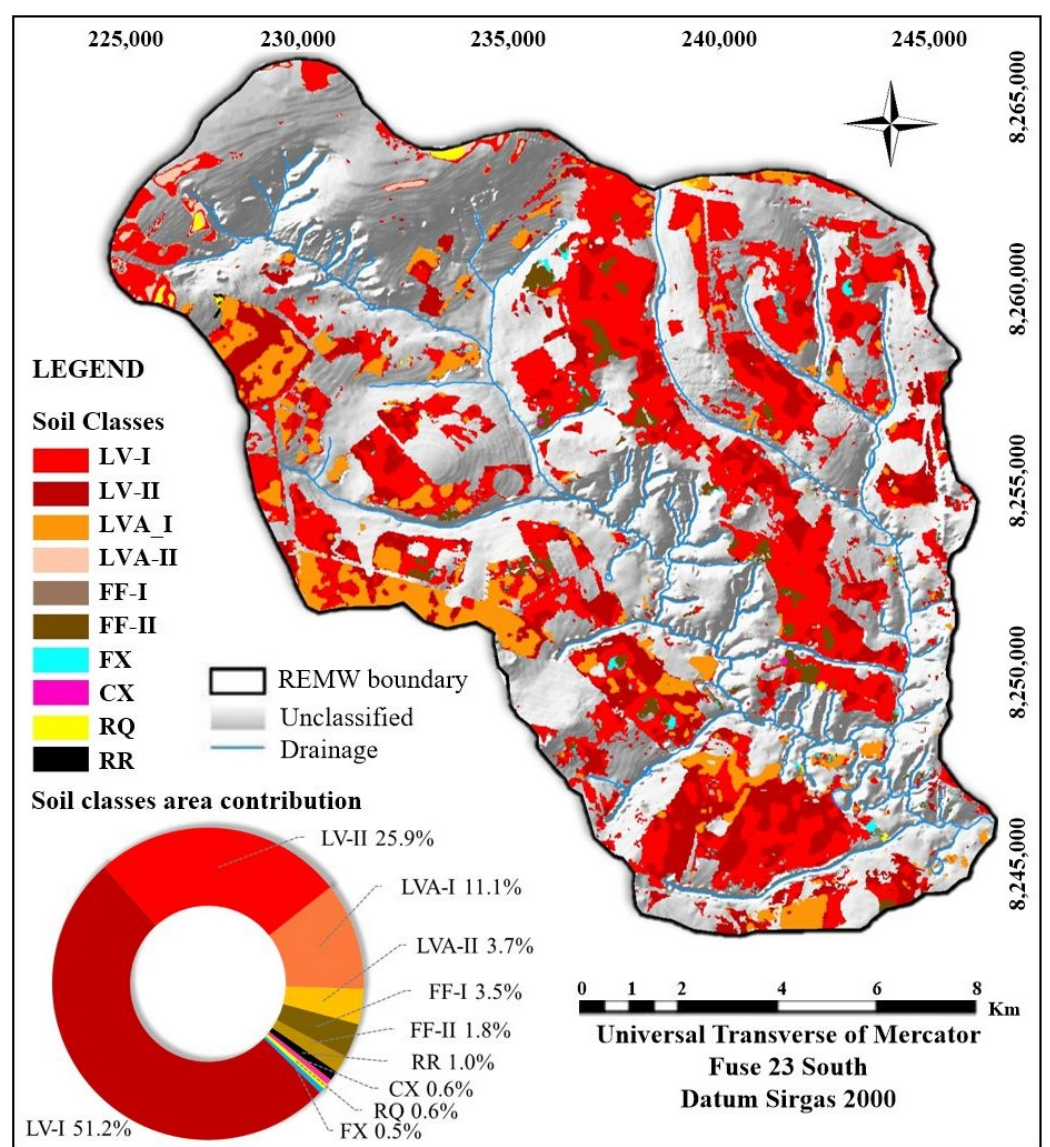
Figure 7. Digital soil classes map of the Ribeirão Extrema microwatershed (RE) with a pie chart showing the contribution percentage of soil classes to the mapped area. LV ‐ I: LATOSSOLO VERMELHO Distrófico típico muito argiloso; LV ‐ II: LATOSSOLO VERMELHO Distrófico típico argiloso; LVA ‐ I: LATOSSOLO VERMELHO ‐ AMARELO Distrófico típico muito argiloso; LVA ‐ II: LATOSSOLO VERMELHO ‐ AMARELO Distrófico típico franco ‐ arenoso; FF ‐ I: PLINTOSSOLO PÉ ‐ TRICO Concrecionário distrófico muito argiloso; FF ‐ II: PLINTOSSOLO PÉTRICO concrecionário distrófico argiloso; RR: NEOSSOLO REGOLÍTICO distrófico argiloso; CX: CAMBISSOLO HÁ ‐ PLICO tb distrófico argiloso; RQ: NEOSSOLO QUARTZARÊNICO Órtico típico distrófico and FX: PLINTOSSOLO HÁPLICO Distrófico típico argiloso. We observed occasional occurrences of Plinthosols (FF and FX) in the residual hills of the landscape. Their spatial representation decreases towards the downstream of the